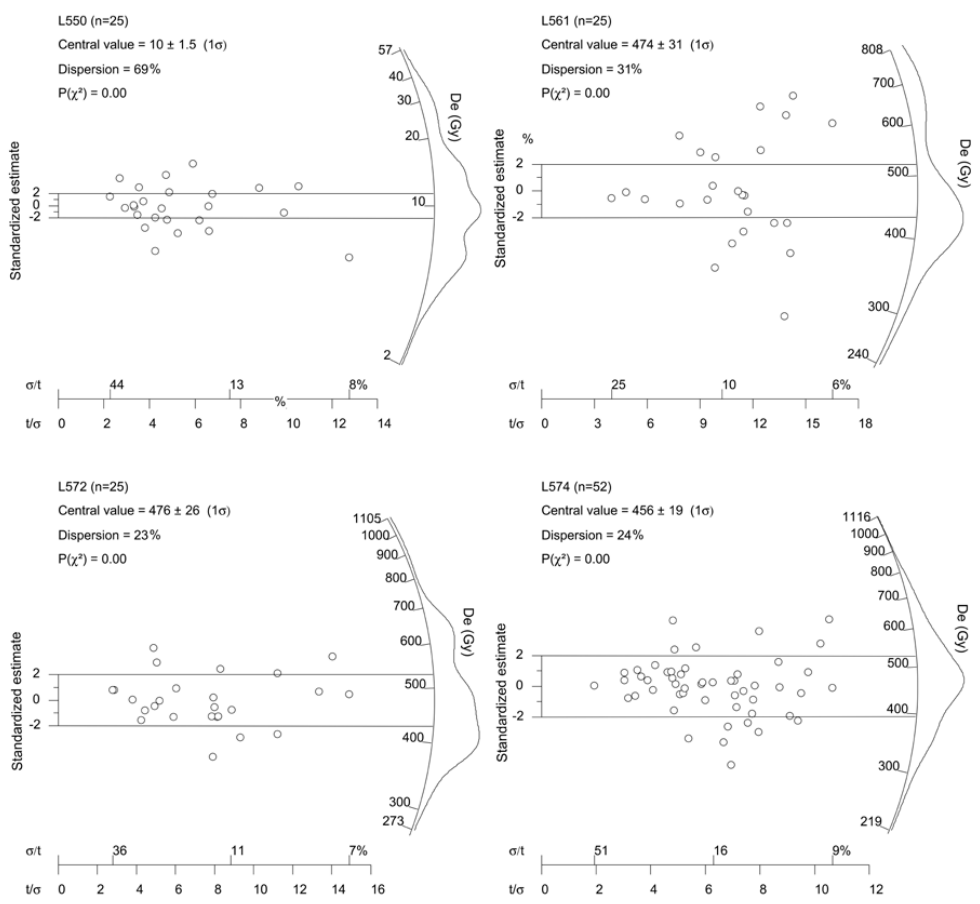
Figure 7. Abanico plots [51] showing the De distribution of four representative samples. The plots were generated using the RadialPlotter software (version 9.5) [52]. An abanico plot is the combination of both radial and kernel density estimate (KDE) plots [53]. It shows a visual correlation between De errors (radial plot) and De frequency distribution (KDE, on the z-axis of the radial plot). σ / t and t / σ refer to relative error (%) and precision, respectively.